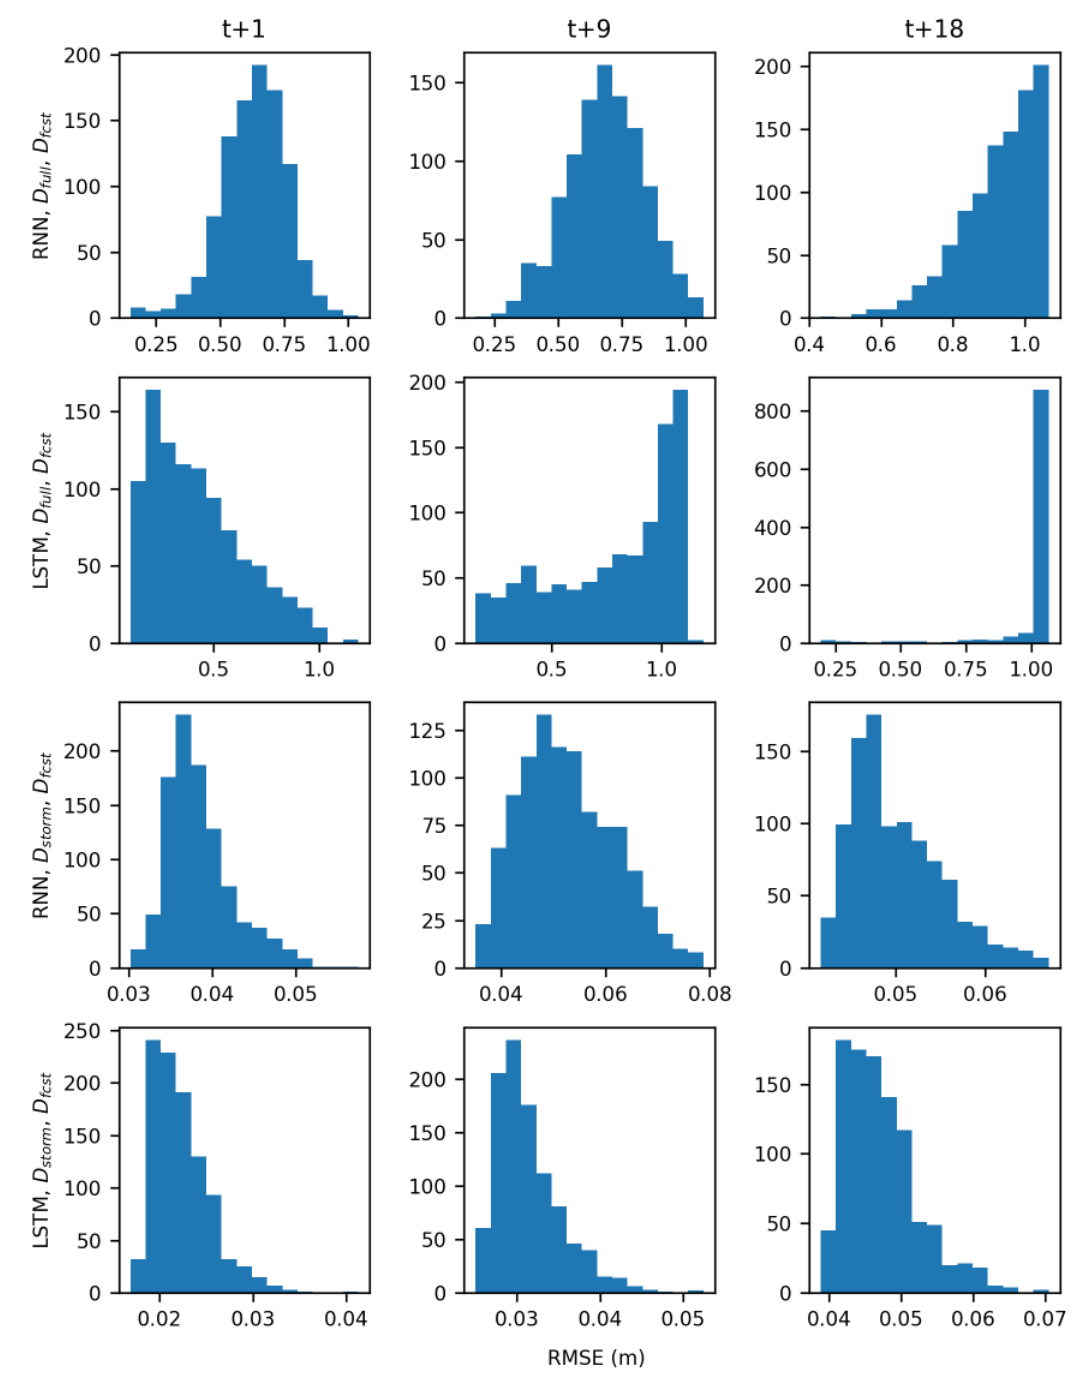
Figure A12. RMSE distributions for GW5 using forecast input data. Columns represent the forecast horizons t + 1, t + 9, and t + 18. Rows are specified as model type, training data, and testing data.